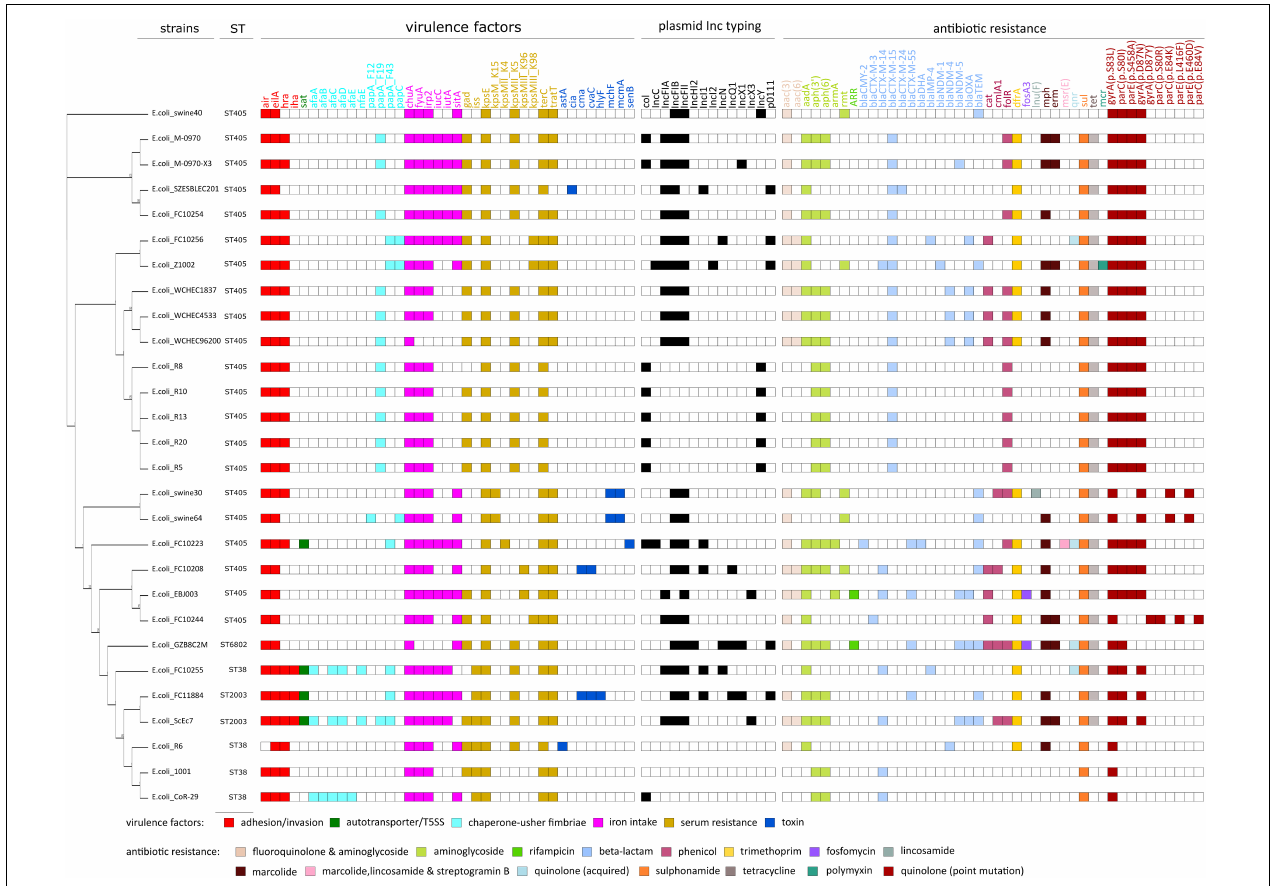
FIGURE 3 | Phylogeny, virulence factors, plasmid profiles, and antibiotic resistance of strain SZESBLEC201 and its genetically similar strains in China. The whole-genome phylogenetic tree was constructed using the maximum likelihood method from concatenated single-copy orthologous genes shared by analyzed genomes. Sequence types, virulence factors, plasmid Inc. typing, and antibiotic resistance were respectively determined by multi-locus sequence typing (MLST), VirulenceFinder, PlasmidFinder, and ResFinder on Center for Genomic